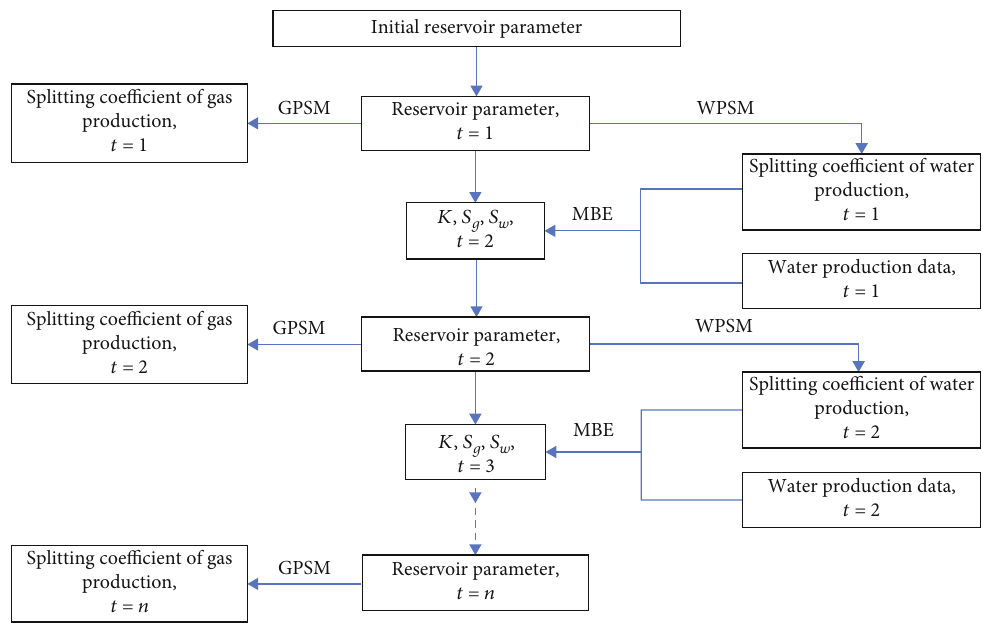
Figure 2: Calculation process of